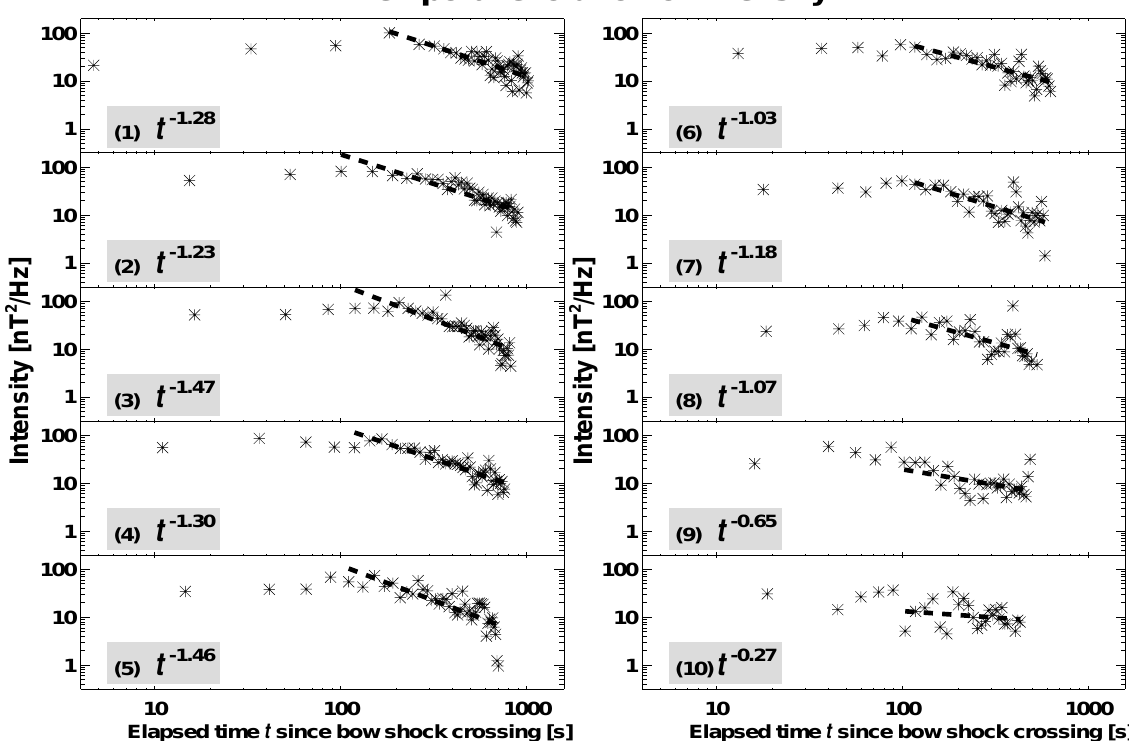
Fig. 10. Wave intensity as function of the elapsed time since bow shock crossing. Numbers in parentheses indicate the evolution curve of the associated streamline in Fig. 7. The asterisks denote the calculated intensity values along a streamline and the dashed lines are straight lines in the double-logarithmic plots which were fitted to the intensities. The straight lines’ slope is in non-logarithmic scale the exponent of a power law and represents thus the strength of the decay. The decay along a particular streamline is indicated by t λ where λ varies between − 0 . 27 and − 1 .